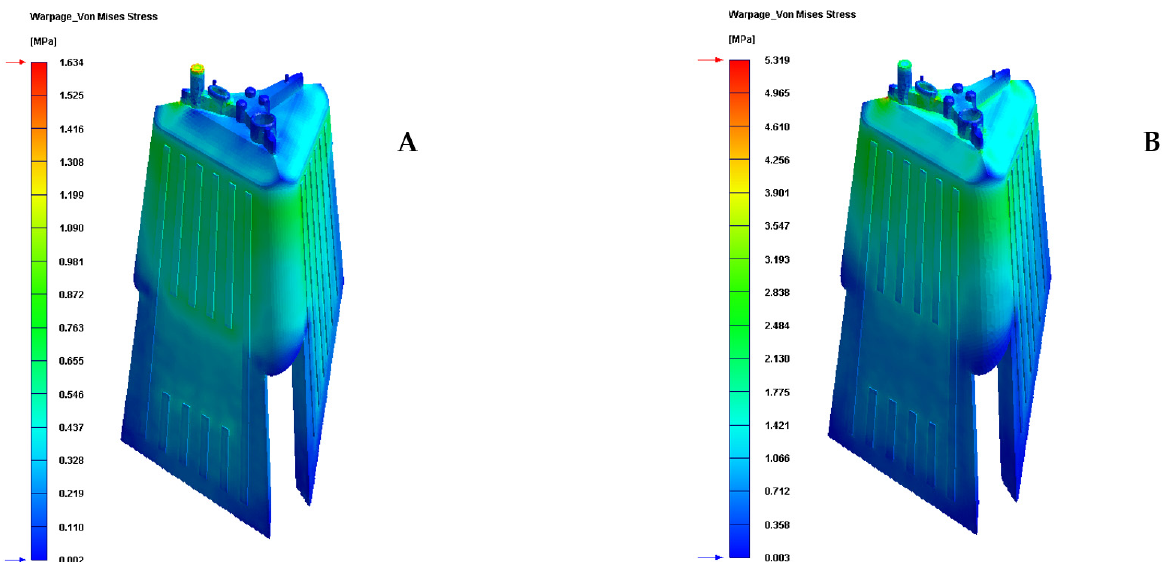
Figure 16. Warpage total displacement (mm). ( A ) New conformal cooling and Fastcool insert. ( B ) Traditional cooling. Table 10. Warpage total displacement for the analyzed cooling systems.